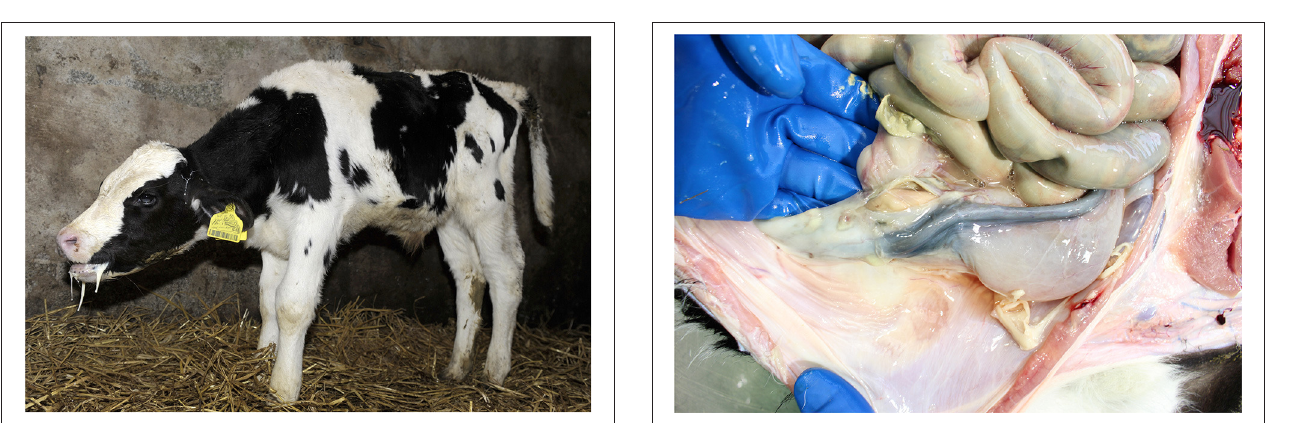
FIGURE 7 | Coughing calf with respiratory disease (Animal Health Ireland).